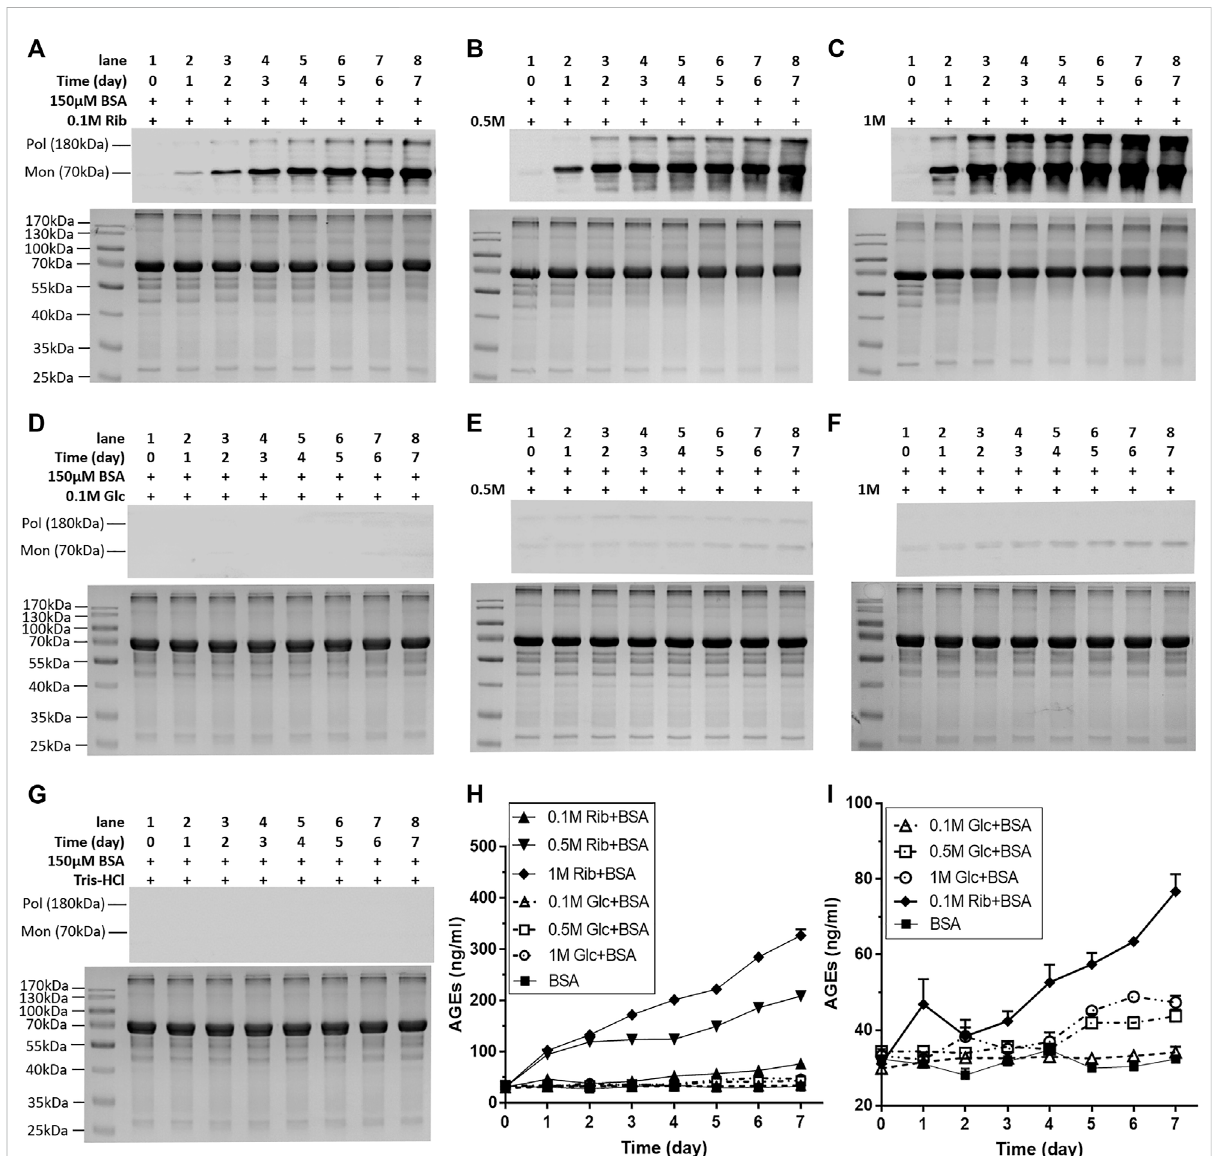
FIGURE 1 Change in AGEs of BSA in the presence of different concentrations of ribose or glucose according to Western blot analysis and ELISAs. BSA ( fi nal concentration, 150 μ M) was incubated with different concentrations of ribose (0.1, 0.5, and 1 M) or glucose (0.1, 0.5, and 1 M) in Tris – HCl buffer (20 mM, pH 7.4) at 37 ° C for 7 days. Aliquots were taken at different time periods for measurements. AGEs were detected by Western blot analysis (A – G) and ELISAs (H,I) . BSA alone was used as the control. (I) Magni fi cation of the y-axis in (H) . Data shown in (H,I) are presented as the mean ± SEM ( n = 3). Abbreviations: Rib, ribose; Glc, glucose; Mon, monomer; Pol,